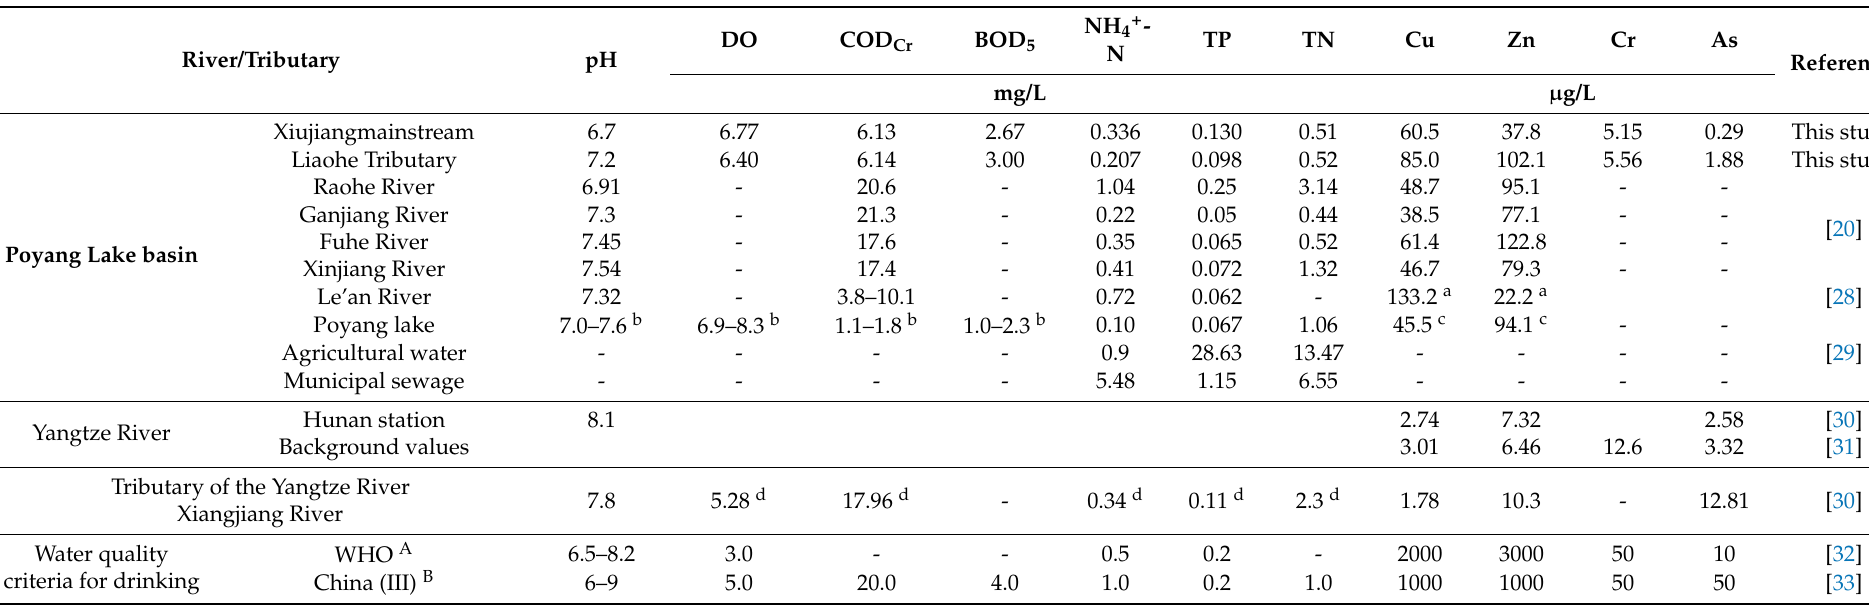
Table 2. Comparison of the pH values, nutrient elements, and average contents of heavy metals of the Xiujiang River and other rivers.